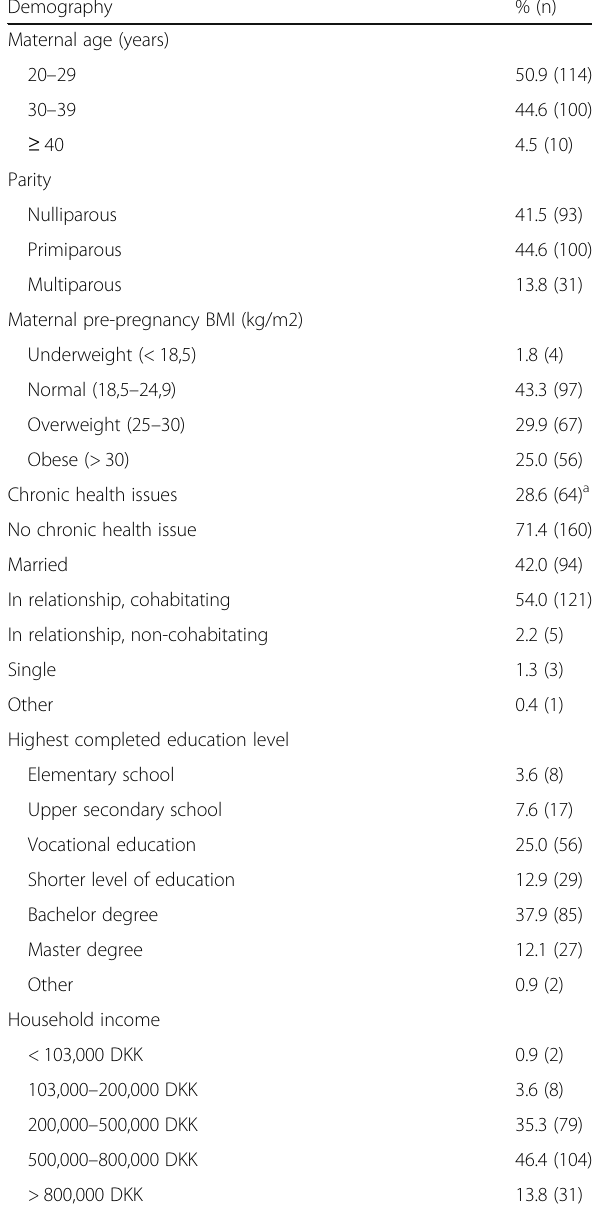
Table 1 Demographic characteristics of the cohort